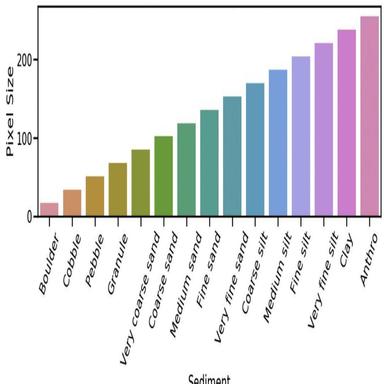
Random Forest classification was used to eliminate the problem of overfitting that is present with decision trees. It also used the pixel size, which was correlated to sediment class. The "anthro" label refers to anthropogenic features such as shipwrecks.